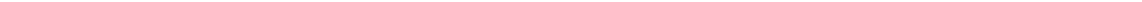
Fig. 2 Repertoire analysis of CH505 Envelope vaccine-induced antibodies. Memory B cells bearing candidate CD4-binding site receptors, or recombinant CD4-binding site antibodies, are termed CH505 differential binders. a Frequency of CH505 differential-binding memory B cells from 12 macaques immunized with CH505 TF envelope (Env) gp120 alone and 16 macaques immunized with sequential combinations of CH505 Env gp120s (sequential + additive). One million peripheral blood cells (PBMCs) from immunized macaques were phenotyped by FACS analysis for memory B cells that had CH505 Env differential binding. Shown is frequency (%) of memory B cells in PBMC that demonstrated CH505 Env differential binding. Number of animals with CH505 differential-binding memory B cells above background at 2 weeks post each immunization is listed above each graph. b Total Env-reactive antibodies isolated from blood memory collected 2 weeks post fourth and sixth immunizations in 16 macaques immunized with CH505 TF alone or sequential combinations of Env gp120, regardless of adjuvant; CH505 differential (CH505-D) and non-differential binders (CH505-ND). c , d Immunogenetics of antibodies isolated from macaques who received similar CH505 Envs, but different adjuvant. Antibody heavy variable (IGHV) gene mutation frequencies ( c ) and CDR3 lengths ( d ) were inferred by Cloanalyst software program and the results shown via box and whiskers plots; box indicates median, and lower and upper quartile ranges, and whiskers indicate minimum and maximum numbers evaluated. e IGHV mutation frequencies, and ( f ) IGHV CDR3 lengths, of total Env-reactive antibodies isolated from macaques regardless of CH505 Env vaccines or adjuvants. c – f Statistical analyses: ( c , d ) P > 0.05 (exact Wilcoxon test with false discovery rate (FDR) correction) — (i) IGHV mutation frequencies or CDR3 lengths of CH505 differentials or non-differentials isolated from animals receiving similar Env vaccines (TF or sequential Envs) in different adjuvants, and (ii) immunogenetics of CH505-D and CH505-ND antibodies isolated from macaques immunized with sequential or additive CH505 Envs in GLA-SE; ( e , f ) P = 0.008 (exact Wilcoxon test with FDR correction) — IGHV mutation frequency and CDR3 lengths for CH505-D and CH505-ND antibodies, regardless of Env vaccines and adjuvants, and (ii) for IGHV CDR3 lengths of CH505-D and non HIV-1-reactive